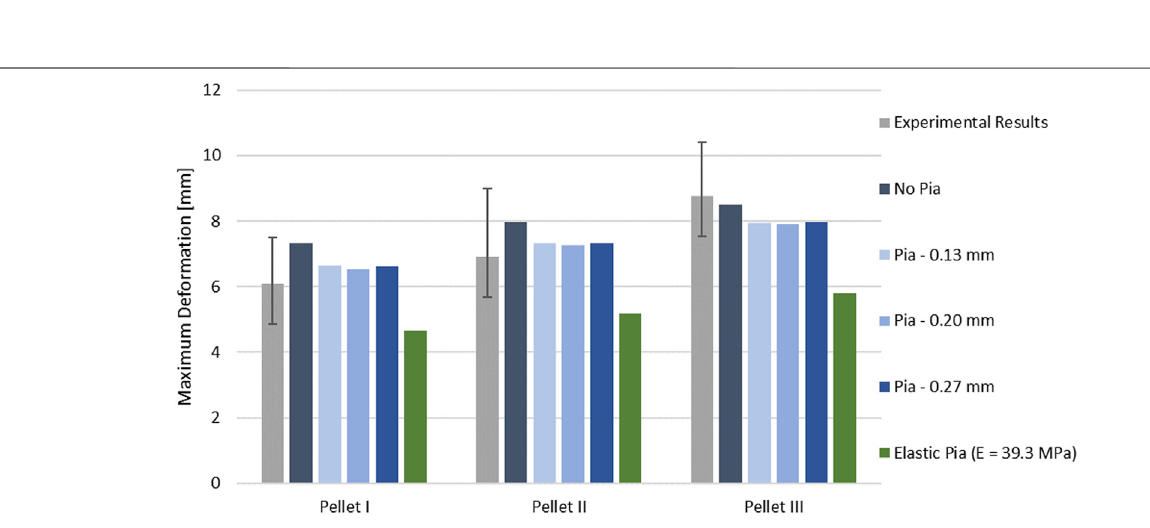
Frontiers in Bioengineering and Biotechnology |